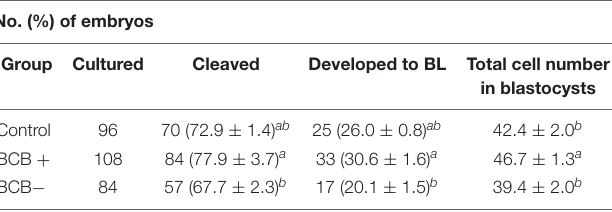
TABLE 3 | In vitro development of porcine cloned embryos derived from brilliant cresyl blue-stained (BCB + ) and non-stained (BCB − ) oocytes.